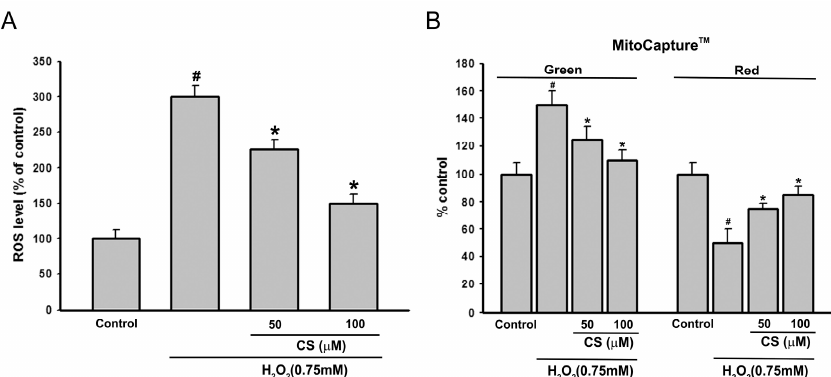
Figure 4. Effect of costunolide (CS) on H 2 O 2 -induced intracellular accumulation of ROS and mitochondria membrane potential (MMP). Intracellular ROS levels and MMP were measured using the MitoCapture™ Kit. PC12 cells were pretreated with various concentrations of CS for 30 min before exposure to 0.75 mM H 2 O 2 for 6 h. ( A ) Histogram showing the ROS level in PC12 cells after treatment with H 2 O 2 in presence or absence of CS compared to untreated groups; ( B ) Histogram showing the number of cells with a low potential in PC12 cells after treatment with H 2 O 2 in presence or absence of CS compared to untreated groups. Cells were stained with MitoCapture™ solution, demonstrating both a reduced number of healthy cells (red signal) and increased number of cells with disrupted mitochondrial potential (green signal) in the presence of CS. Data are presented as mean ± SD ( n = 3). Values with the same superscript letters are not significantly different from each other at # p < 0.01 compared with the control group; * p < 0.05, compared with the model group.